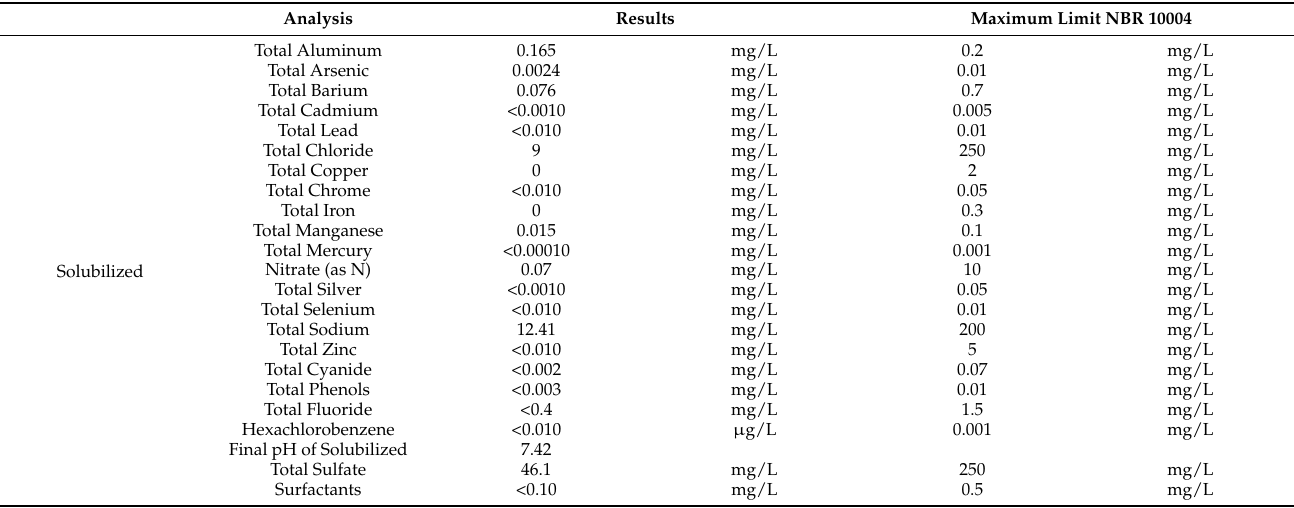
Table 5. Analytical results of the solubilization